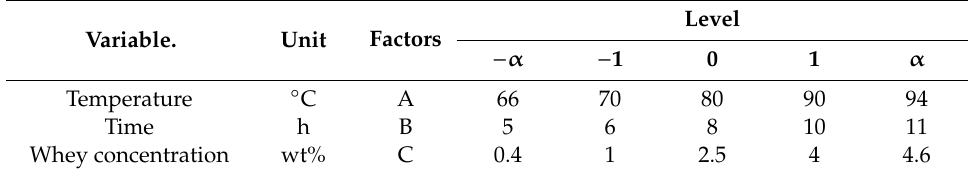
Table 1. Description of the central composite design (CCD) used for WPF preparation and its impact on mercury and chromium removal from